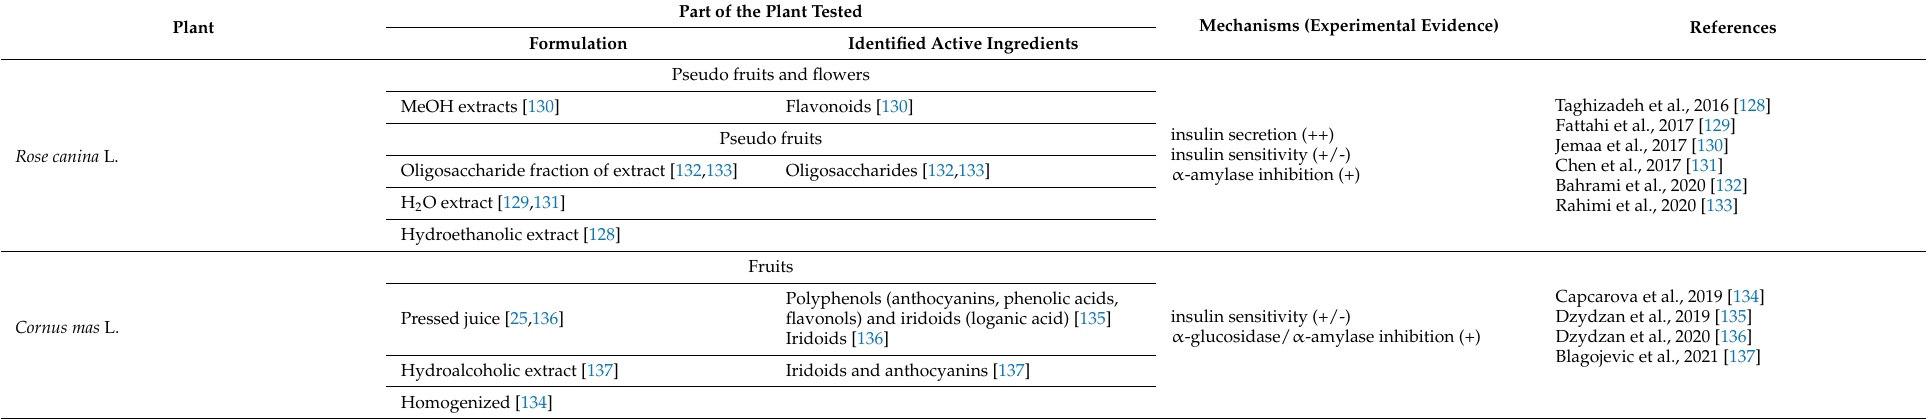
Table 2. Plants used in the Occitan valleys of the Piedmont Alps: potential direct anti-diabetic mechanisms (experimental evidence between 2011 and 2021).